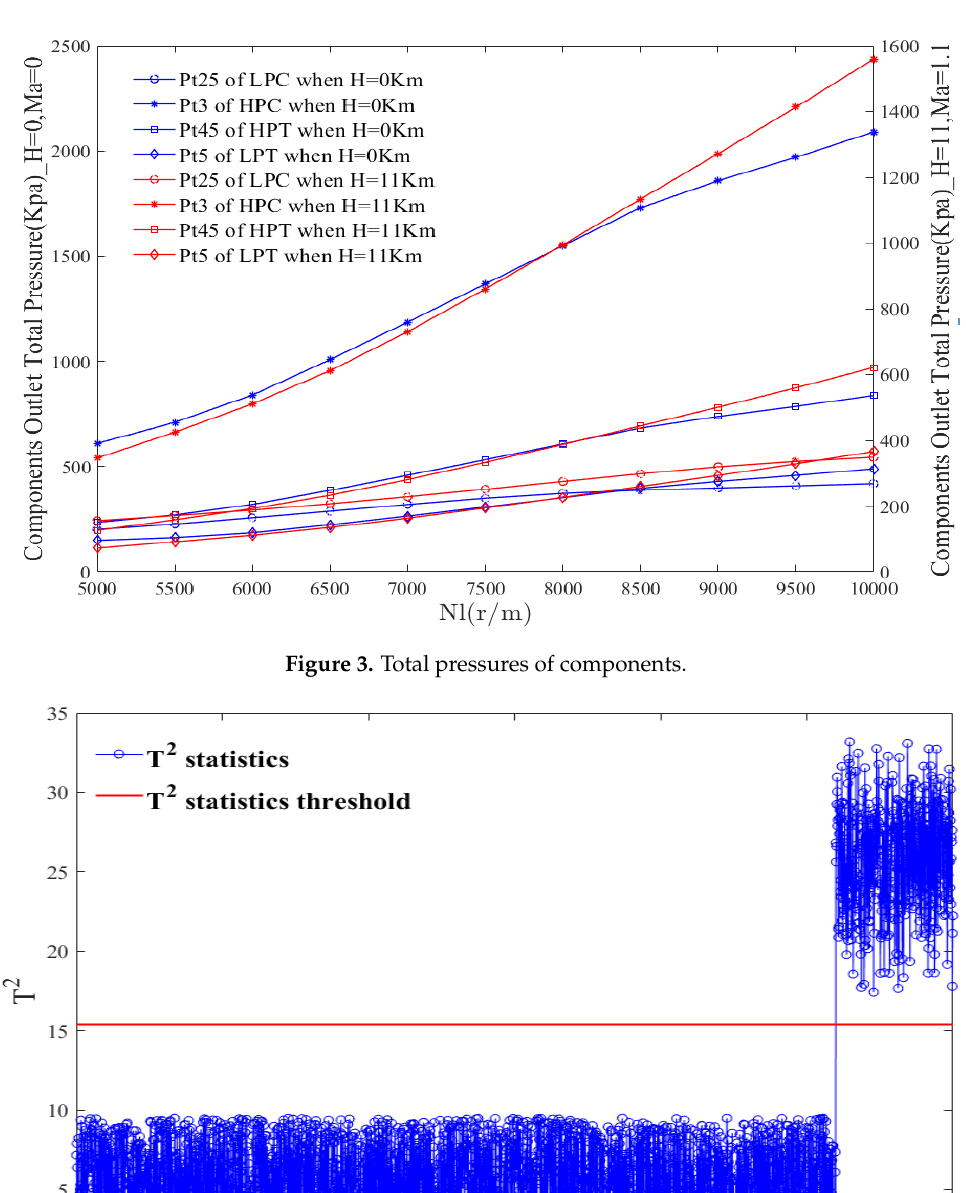
Figure 5. Value of SPE statistic under the condition of LPC fault.